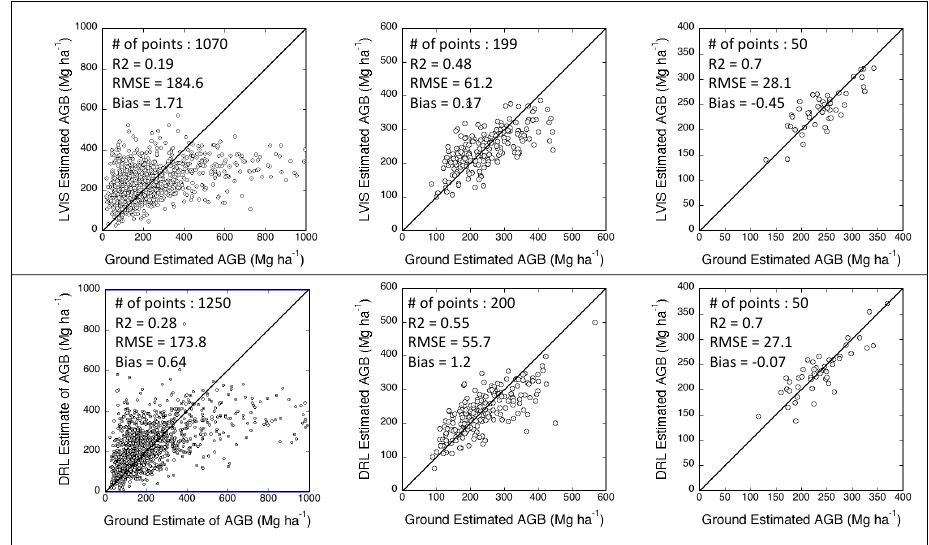
Fig. 5. Relationship between ground-estimated AGB and lidar-estimated AGB (top : LVIS, bottom : DRL), using five height metrics in the regression model. The correlation between the two estimations of AGB increases as the scale becomes